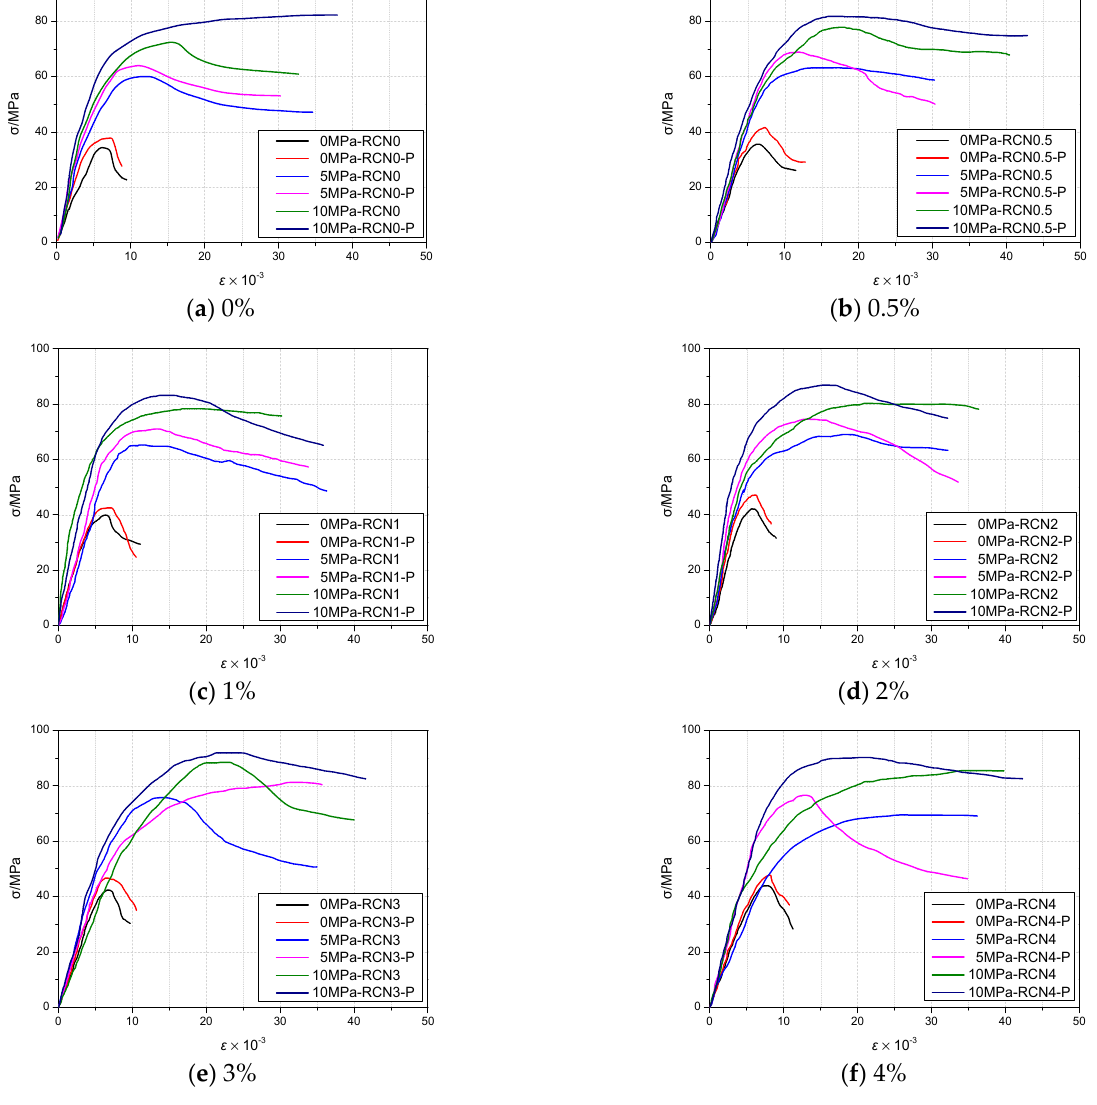
Figure 5. Changes of NS content under different confining pressures and stress-strain relationship curves of recycled aggregate concrete with and without PVA fibers.